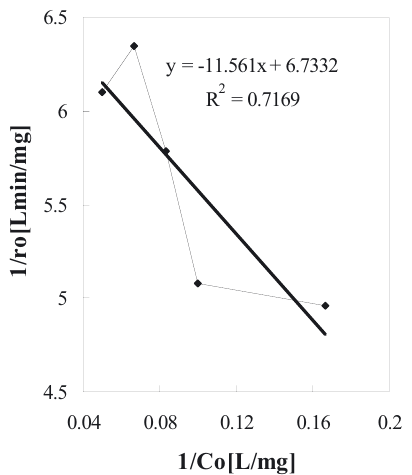
Figure 6. The linear transformation of 1/r